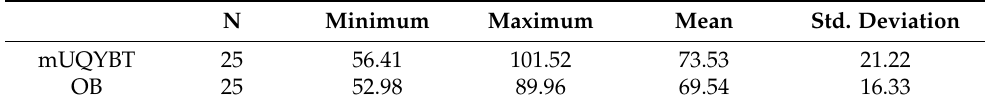
Table 4. Modified-Upper Quarter Y-Balance test and OctoBalance test week 1. N Minimum mUQYBT OB Variables of mUQYBT in week 1 obtained values of 99.87 ± 12.93 cm (right medial), 101.51 ± 12.03 cm (left medial), 56.41 ± 11.40 cm (right superolateral), 57.80 ± 10.26 cm